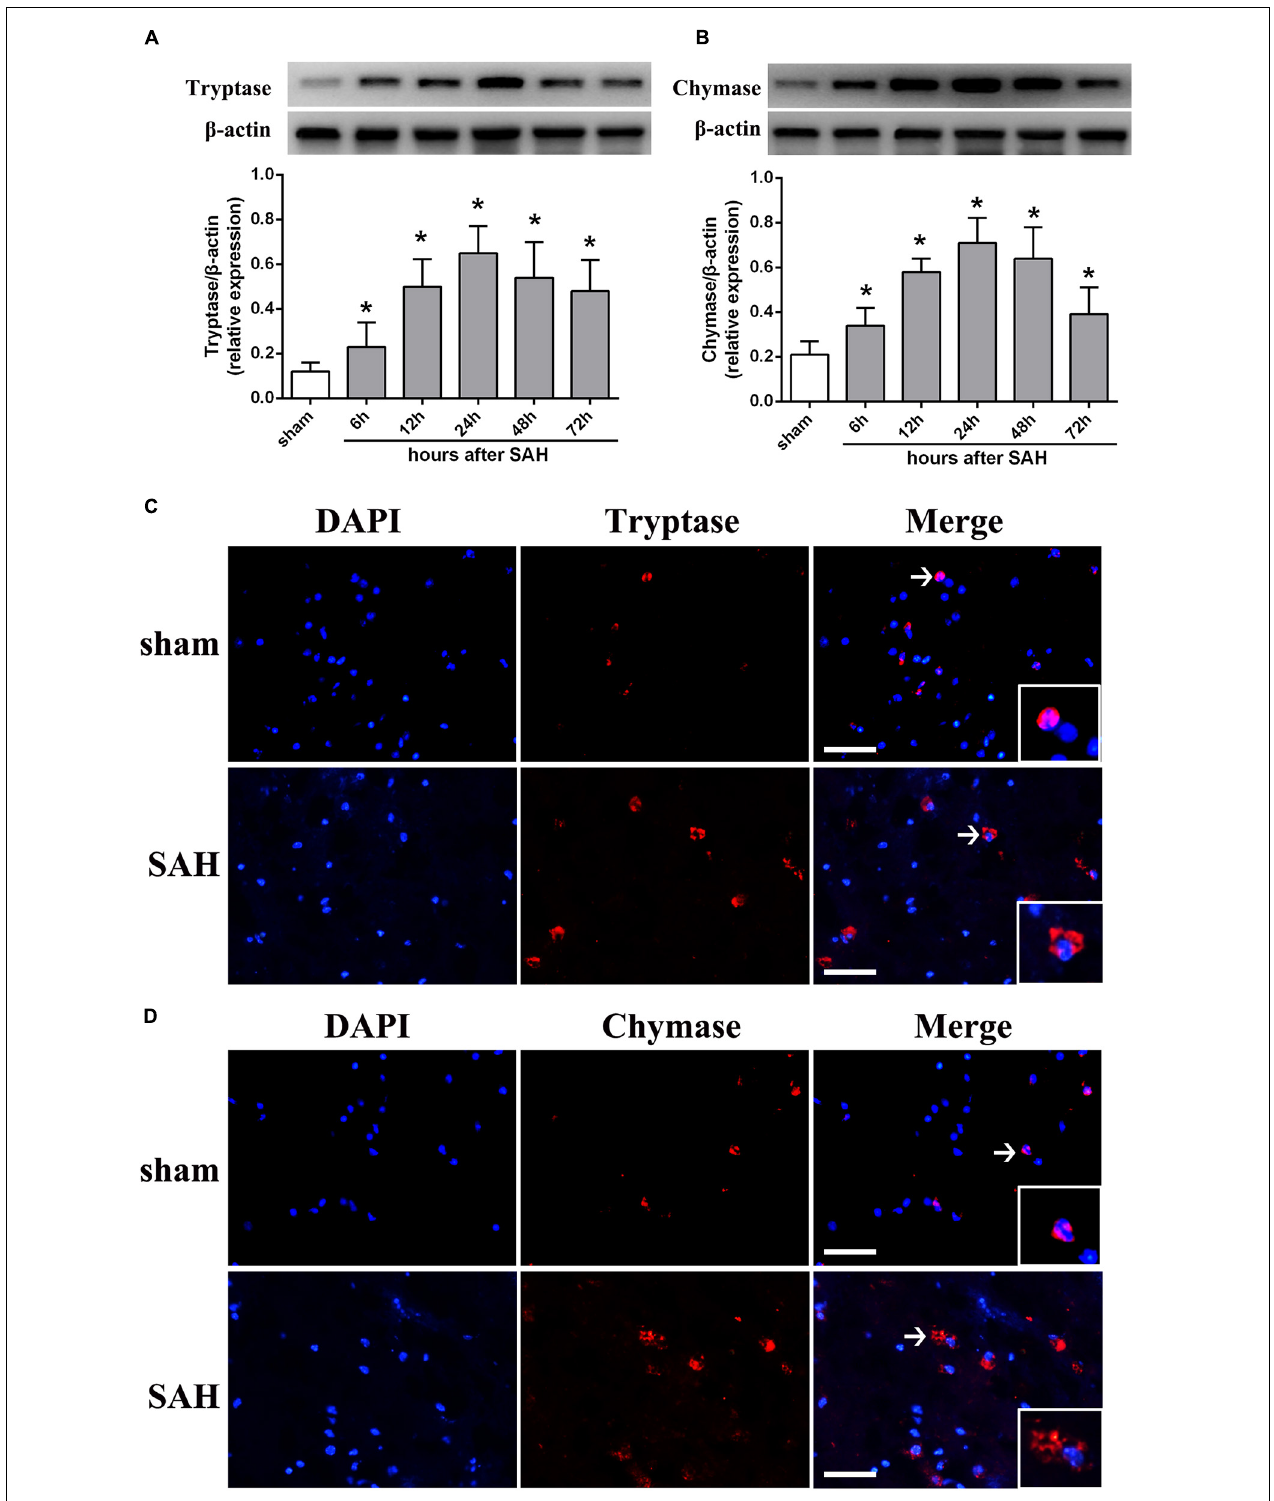
FIGURE 1 | The expression pattern of MCs-derived tryptase and chymase after SAH. (A,B) Representative western blotting images and quantitative analyses of tryptase and chymase expression in ipsilateral basal cortex after SAH. n = 6. The bars represent the mean ± SD. * P < 0.05 versus sham. (C,D) Representative microphotographs of immunofluorescence double staining showing the expression and distribution of tryptase and chymase in sham group and SAH 24 h group. Scale bar = 50 µ m.